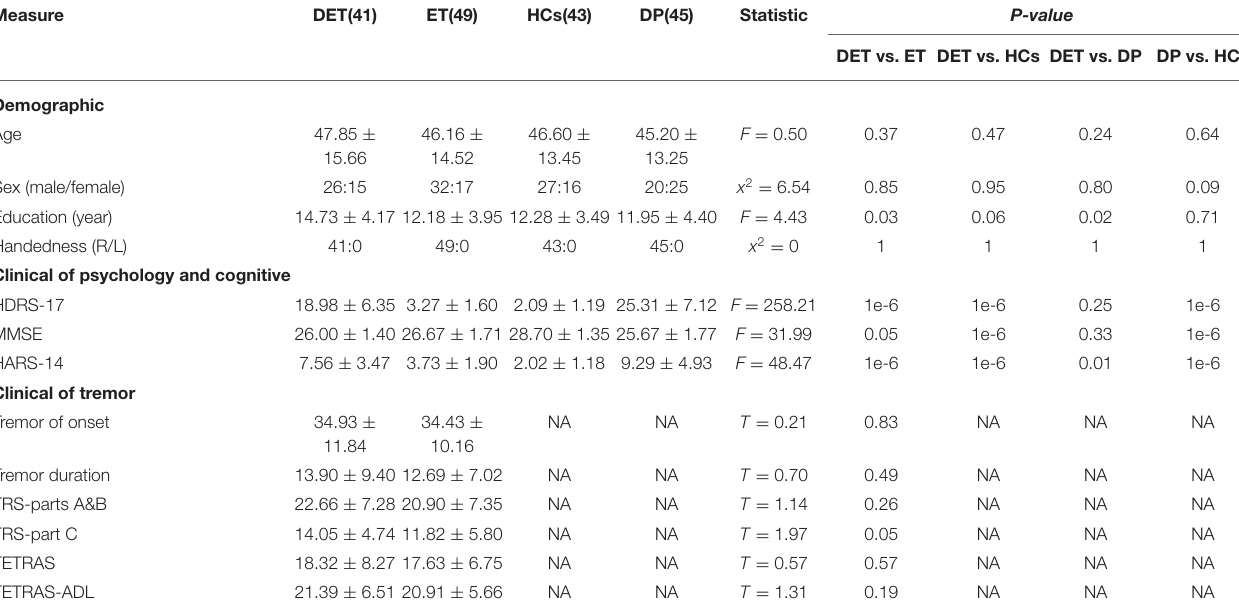
TABLE 1 | Demographic and clinical features of depressed ET, non-depressed ET, HCs, and DP. Measure DET(41) Statistic